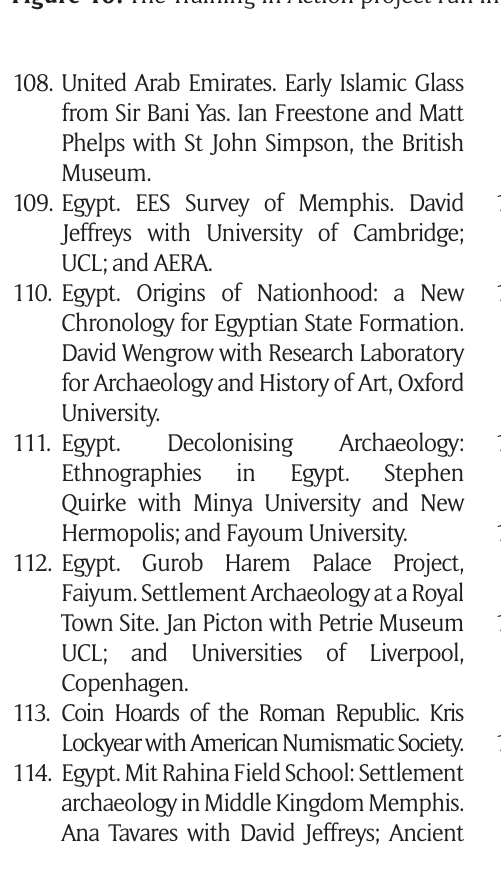
Figure 10: The Training in Action project run in Tunisia and Libya (Photo: Gaigysyz